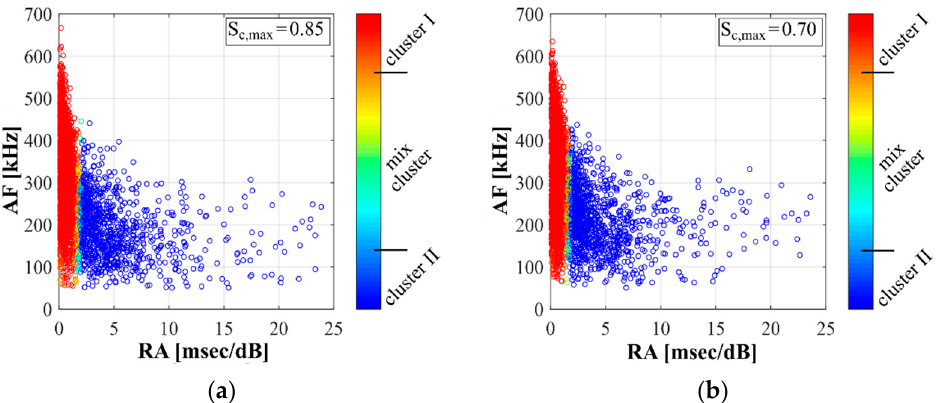
Figure 4. AE-hits of a full test in the RA/AF space and assignment to clusters, for S c,max = 0.85 ( a ) and S c,max = 0.70 ( b ). and S c,max = 0.70 ( b